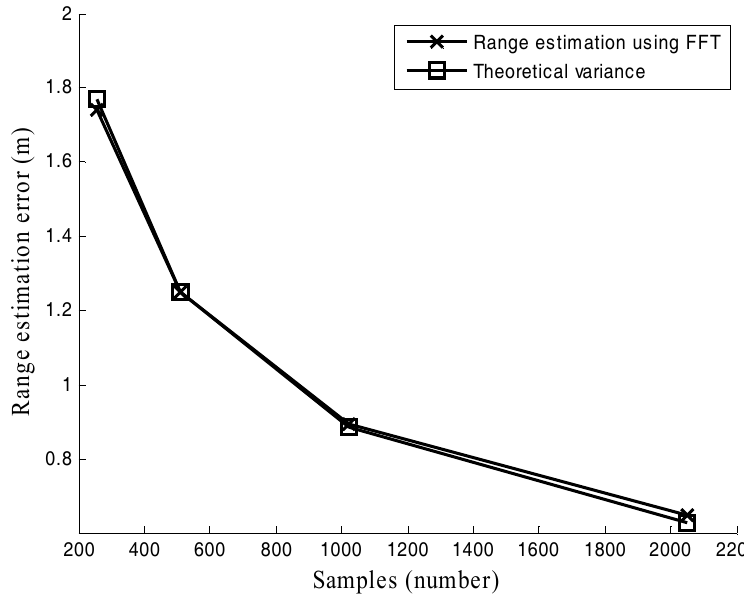
Figure 4. Range estimation error under different numbers of samples (M).